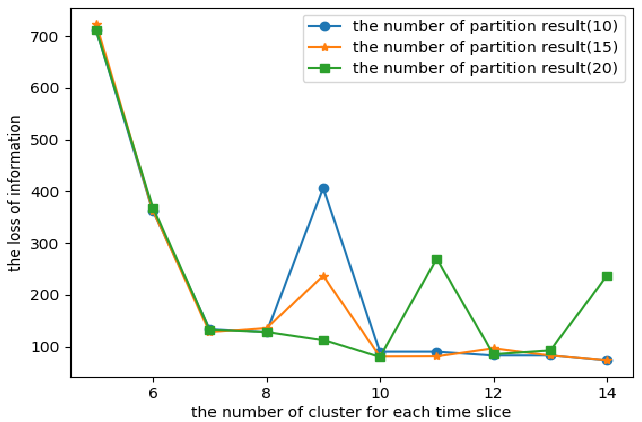
Figure 8. The loss of information (Geolif dataset).